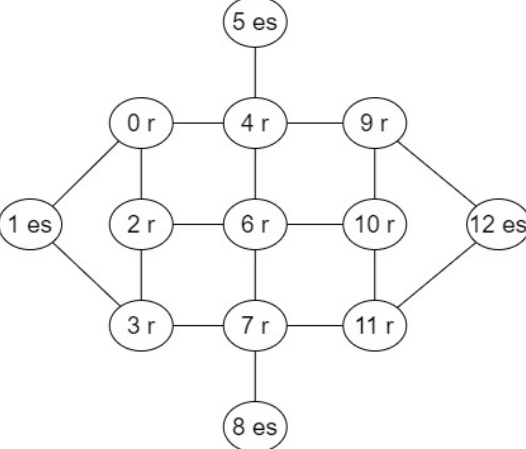
Figure 2. Physical structure of a platform